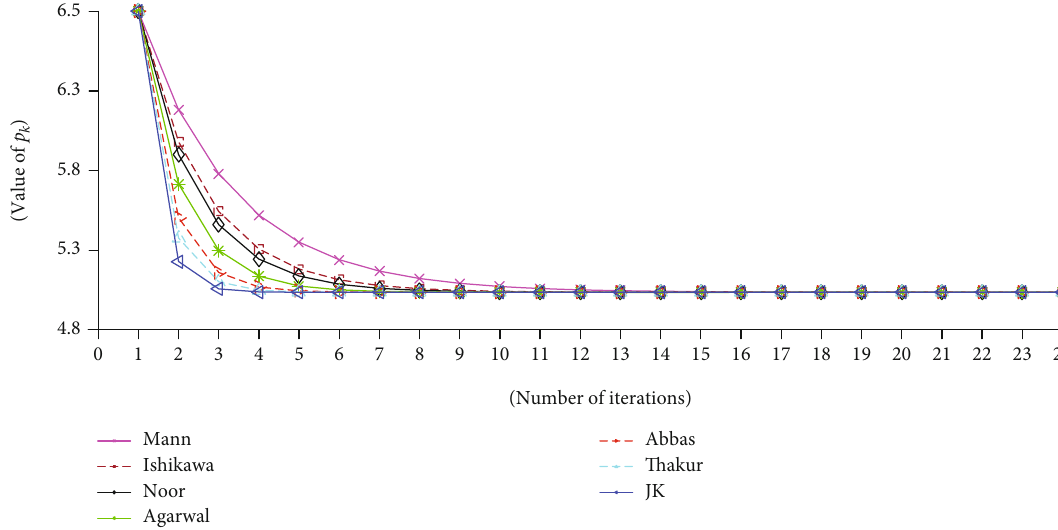
Figure 1: Convergence behavior of the sequences developed by remarkable iterative